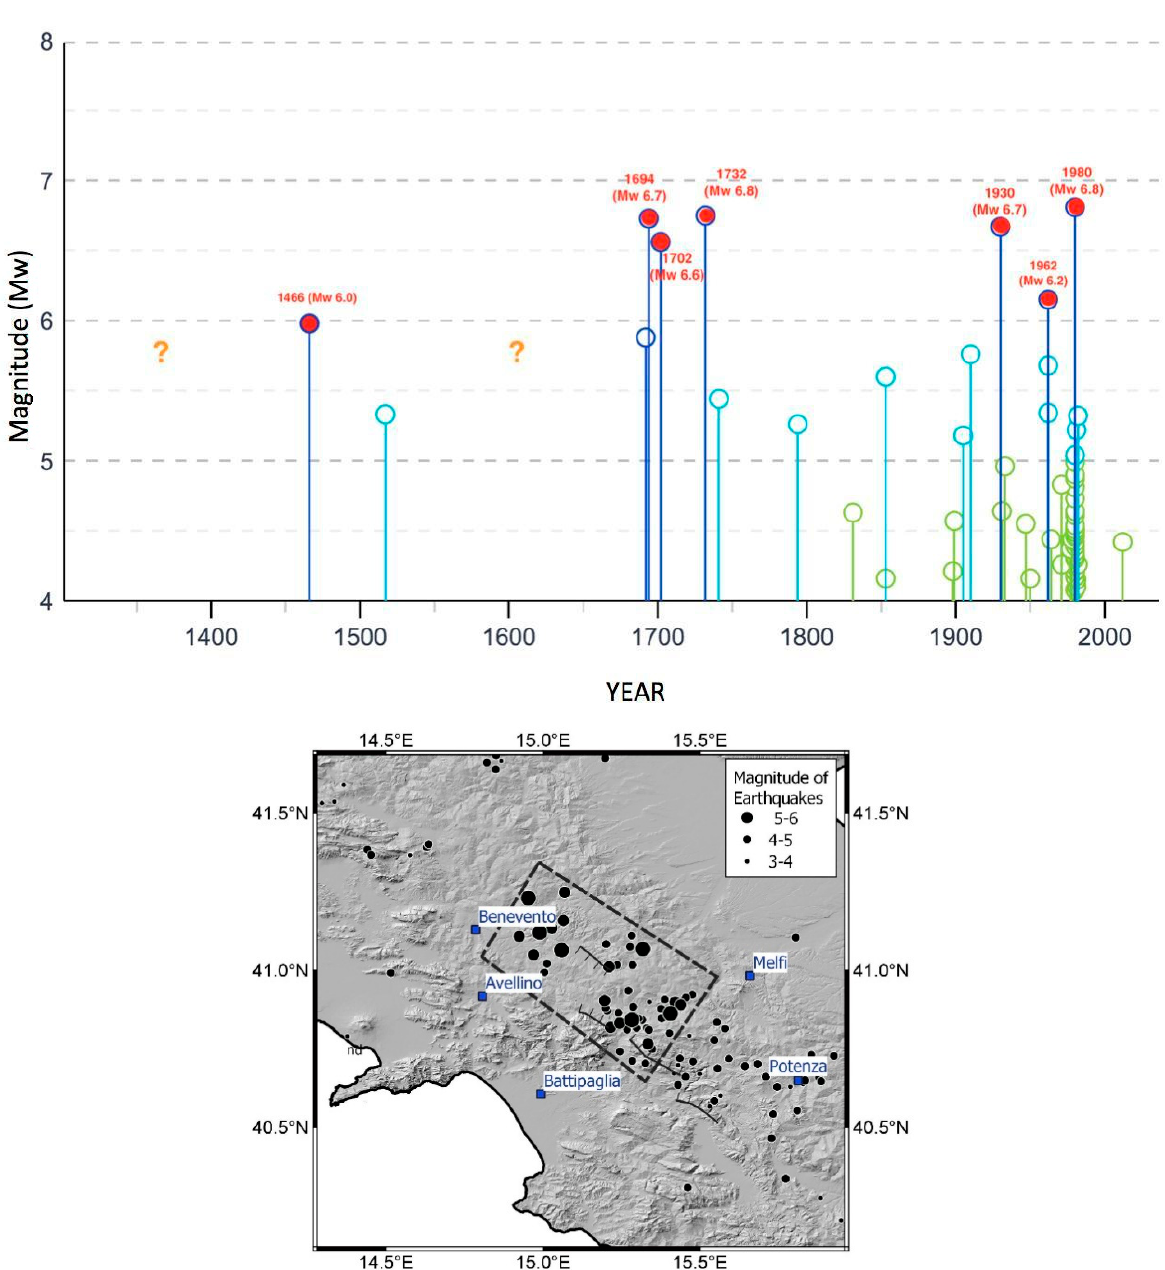
Figure 6. ( Top ) Seismic history of the Irpinia area as from the CPTI15 catalog [26]. The dark red polygonal area shows the Irpinian main seismic belt, the coordinates of its vertices are: 41.314 ◦ N, 14.971 ◦ E; 41.105 ◦ N, 14.874 ◦ E; 40.739 ◦ N, 15.352 ◦ E; 41.056 ◦ N, 15.574 ◦ E. Such a historical record is well documented only for the last 400 years (namely since 1620 [27]), whereas for the previous centuries it is poorly known, with long timespans lacking information. The figure also shows that inside the catalog completeness span-time of 400 years (since 1620), there are a couple of evident clusters of strong earthquakes (Mw ≥ 6.0) which are 200-years apart. The first, between 1694 and 1732, when three M 6.5+ events occurred over a period of 38 years. The second, between 1930 and 1980, when three M 6.0+ events occurred over a period of 50 years. ( Bottom ). Map of the main historical seismic events of Irpinia from 1466 until 1982, reported in Table 1. The main towns of the area are drawn and labeled with dark blue squares, and the main faults (see Figure 2 (top)) are represented with black hashed lines.